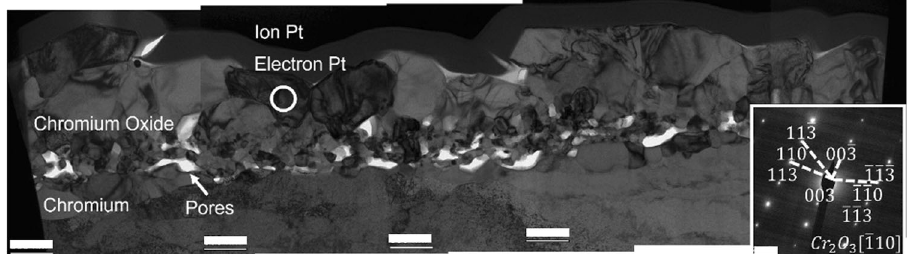
Fig. 2 TEM bright fi eld micrograph of chromium sample oxidized in air for 5 days at 700 °C. The formation of chromium oxide (evident from selected area electron diffraction pattern) is shown as well as pores which are mostly found at the metal/oxide interface. Scale bar for TEM: 500 nm. Scale bar for SAED: 2